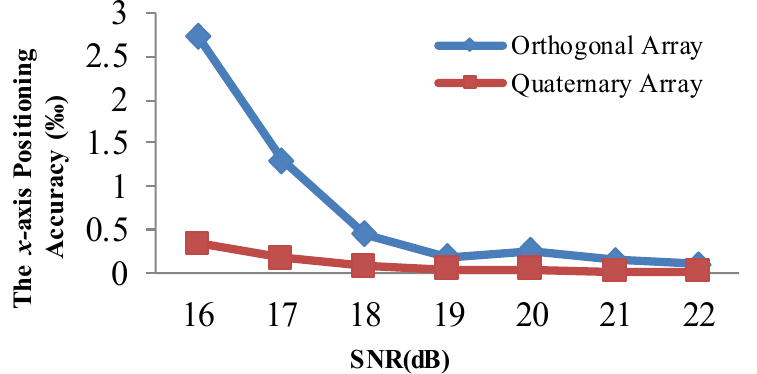
Figure 11. Comparison of the x-axis positioning accuracy of the adaptive algorithm for different arrays and different SNR values. Figure 12. Comparison of the x-axis positioning accuracy of Kalman filtering for different arrays and different SNR values. Figures 10–12 illustrate that the x -axis positioning accuracy with the quaternary ar- ray is higher than that with the traditional array. More specifically, their accuracy with the quaternary array is higher than that with the traditional array, 7.98-fold, 6.54-fold, and 7.99-fold under these three positioning methods. We performed the same comparison for the y -axis, as shown in Figures 13–15. The positioning results illustrate that the y -axis positioning accuracy with the quaternary ar- ray is higher than that with the traditional array. More specifically, the accuracy with the quaternary array is higher than that with the traditional array, 6.38-fold, 6.47-fold, and 6.84-fold, respectively; this is mainly because the quaternary array adopts a long size, which could reduce the negative effect of noise on the position accuracy. From Figures 10–15, we can conclude that the quaternary array is a more suitable array when the acoustic positioning system is under deployment. 0 0.20.40.60.811.21.4 1.61.8